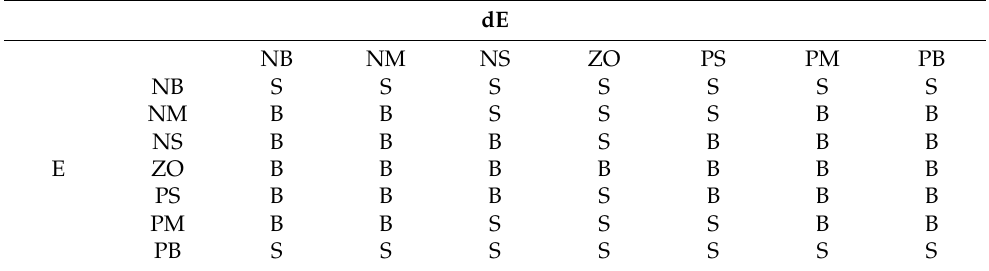
Figure 10. ( a ) Membership function of E and dE. ( b ) Membership function of K p and K d . ( c ) Member- ship function of α Table. Table 1. Fuzzy tunning rules for K ′ p .